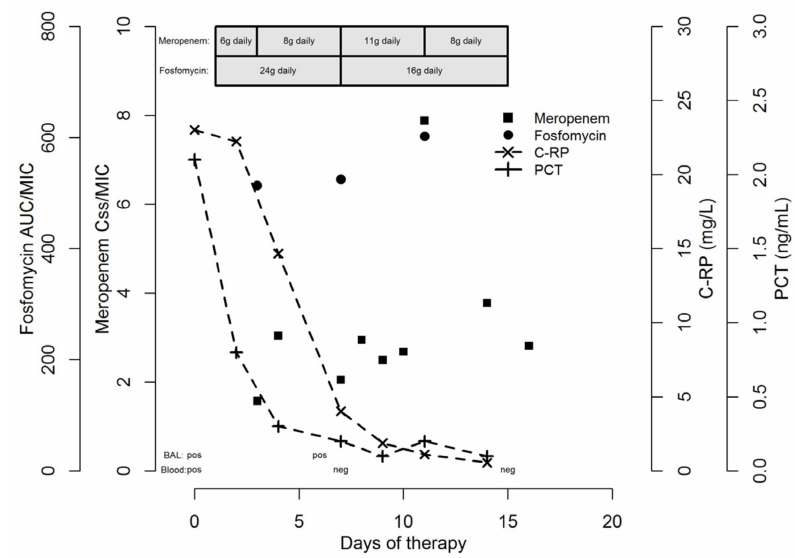
Figure 1. Temporal trends of pharmacokinetic/pharmacodynamic indices of meropenem (Css/MIC) and fosfomycin (AUC 24h /MIC), as well as a reduction in inflammatory biomarkers (C-reactive protein and procalcitonin). AUC 24h , 24 h area under the plasma concentration–time curve; Css, steady-state concentration; C-RP, C-reactive protein; PCT, procalcitonin; and MIC, minimum inhibitory